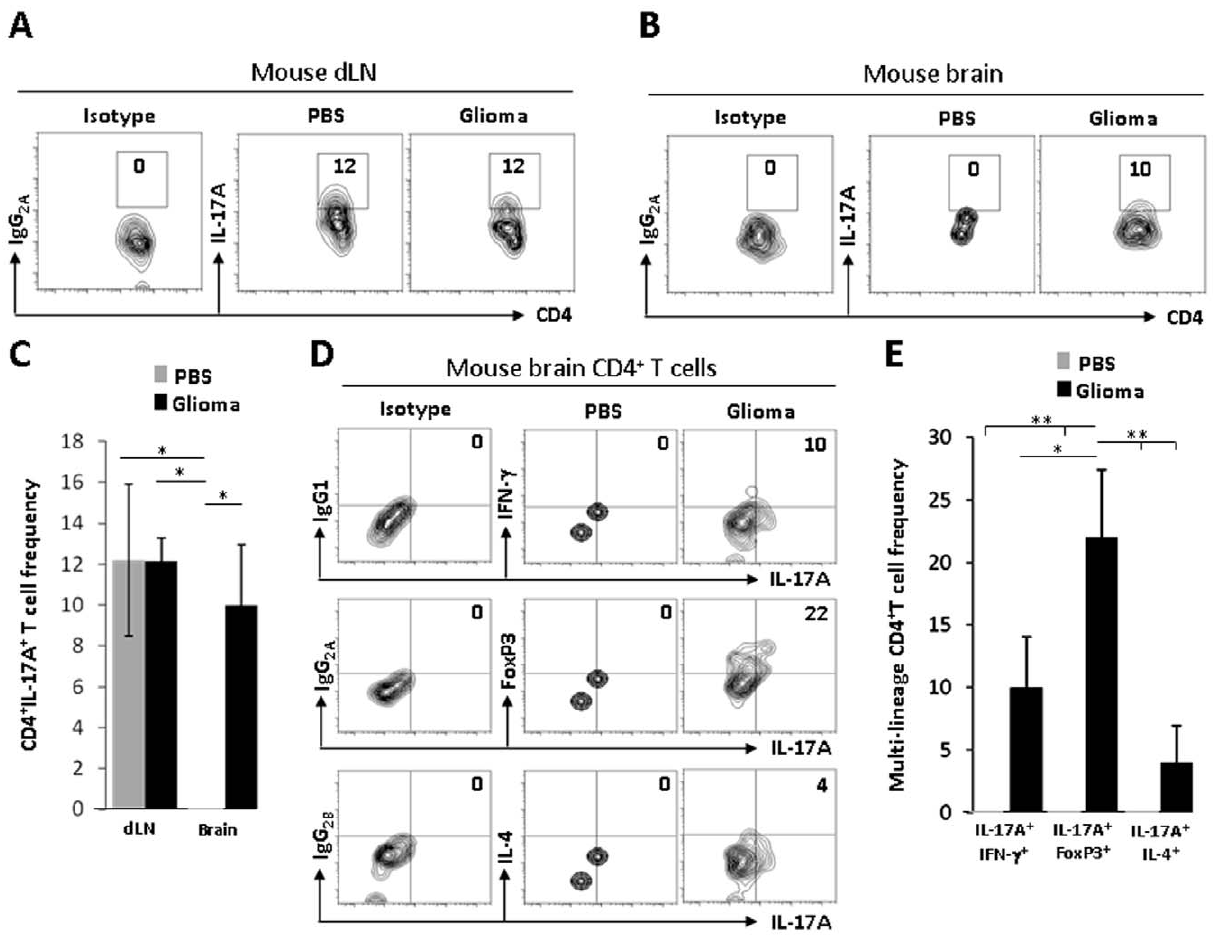
Figure 3. Th17 cell phenotype in dLN and mouse brain with or without a GL261 cell injection. (A) Analysis of draining lymph nodes for CD4 + IgG2A + (isotype control) or CD4 + IL-17A + cells in mice that received an intracranial (IC) injection of PBS or 4 6 10 5 GL261 cells (Glioma). (B) Analysis of brains for CD4 + IgG2A + (isotype control) or CD4 + IL-17A + cells in mice that received an IC injection of PBS or 4 6 10 5 GL261 cells (Glioma). (C) Average CD4 + IL-17A + cell frequency in dLNs or brains ( 6 SEM). (D) Analysis of brains for CD4 + IL-17A + IgG1 + (isotype control) or CD4 + IL-17A + IFN- c + cells (1 st row), CD4 + IL-17A + IgG 2A + (isotype control) or CD4 + IL-17A + FoxP3 + cells (2 nd row) and CD4 + IL-17A + IgG 2B + (isotype control) or CD4 + IL-17A + IL-4 + cells (4 th row) in mice that received an intracranial injection of PBS or 4 6 10 5 GL261 cells (Glioma). (E) Average CD4 + IL-17A + IFN- c + , CD4 + IL-17A + FoxP3 + , and CD4 + IL-17A + IL-4 + cell frequency in brains ( 6 SEM). Data are representative of at least 2 independent experiments. * and ** denotes significant differences at p # 0.05 and p # 0.01, respectively.